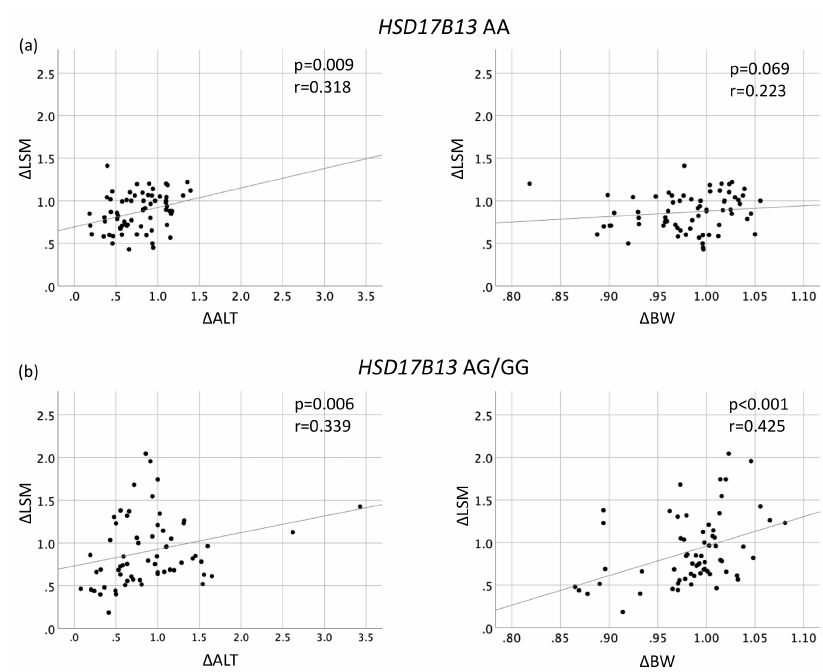
Figure 3. Correlation between changes in liver stiffness measurement and changes in serum ALT level, and in body weight in patients with ( a ) HSD17B13 rs6834314 AA, ( b ) HSD17B13 rs6834314